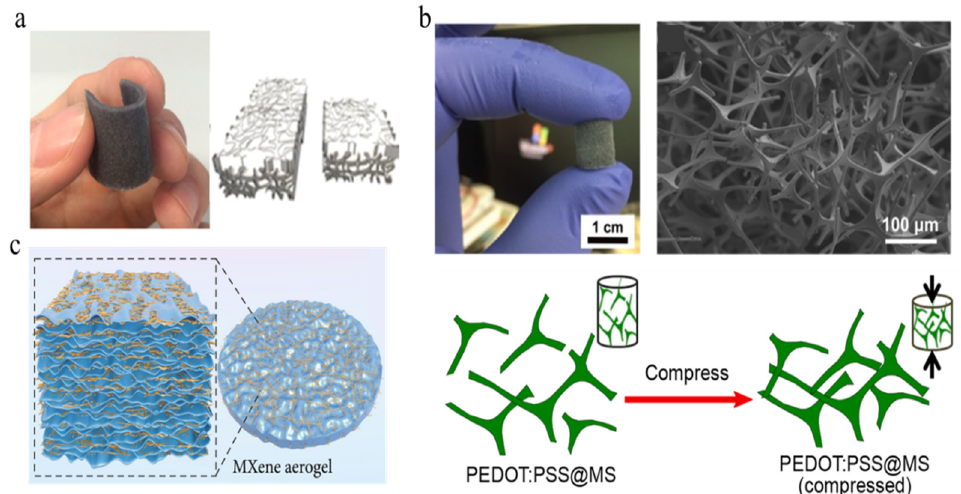
Figure 4. Schematic of pressure sensor based on porous composite material. ( a ) Photograph of a bendable porous composite sensor with GPN-PDMS and Schematic of the porous structure [124]. ( b ) Photograph of PEDOT:PSS-coated melamine sponge, SEM image of the porous sponge, and schematic of structural change under compression [129]. ( c ) Schematic of 3D porous sensor composed of MXene aerogel [137].